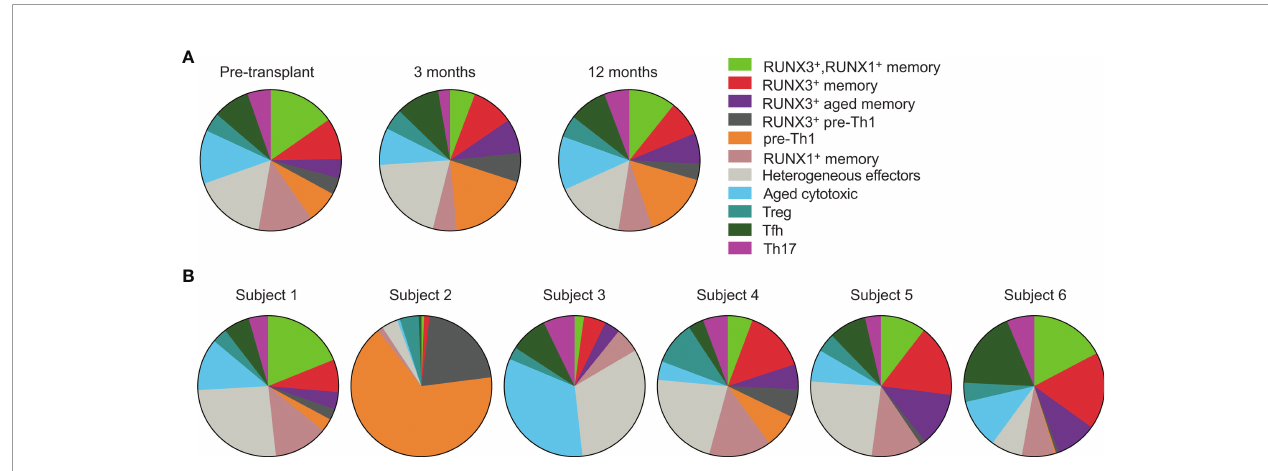
FIGURE 3 | CMV-responsive CD4 T cells have similar phenotypes across subjects and time points. Cell clusters were de fi ned in Figure 2 . (A) CD4 + gated cells from all six subjects were concatenated for analysis by (A) time point and (B) individual subject. Data were analyzed (A) pre-transplant, 3 months, and 12 months post-transplant on 392 cells, 330 cells, and 400 cells, respectively, and (B) across subjects 1-6 on 201, 161, 239, 140, 163 and 318 cells, respectively. n=6